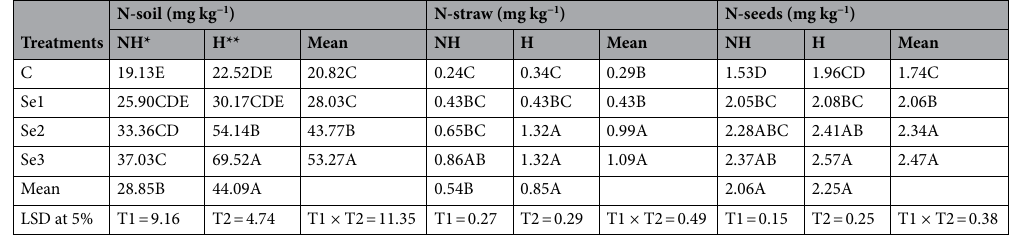
Table 2. Effect of selenium and K-humate on nitrogen content. *Refers to Se application without K-humate. **Refers to the simultaneous application of Se and K-humate.